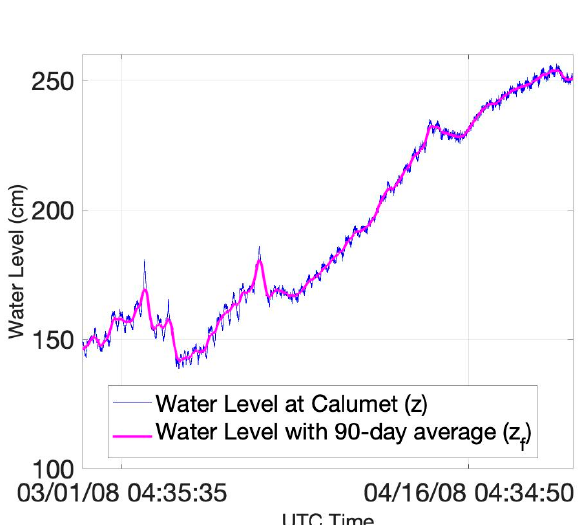
Table 4. Estimation of River Discharge Contribution from Water Level at Calumet.